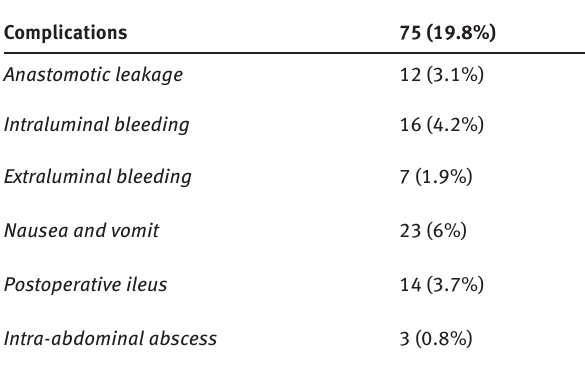
Table 2: Postoperative complications